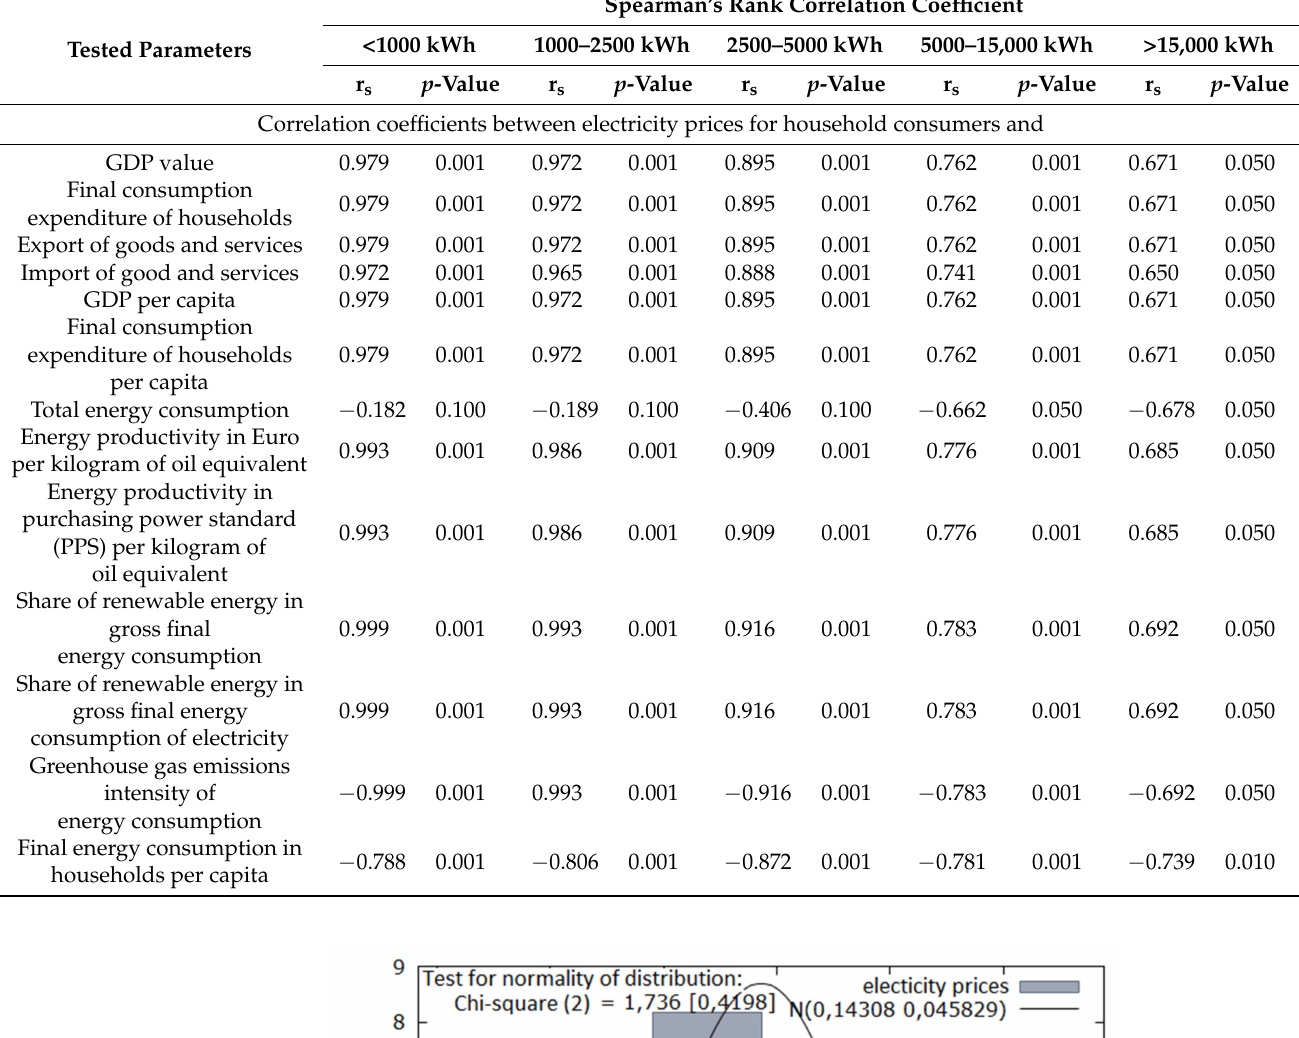
Table 4. Spearman’s rank correlation coefficients between energy economy parameters and the electricity prices for private customers in the EU.